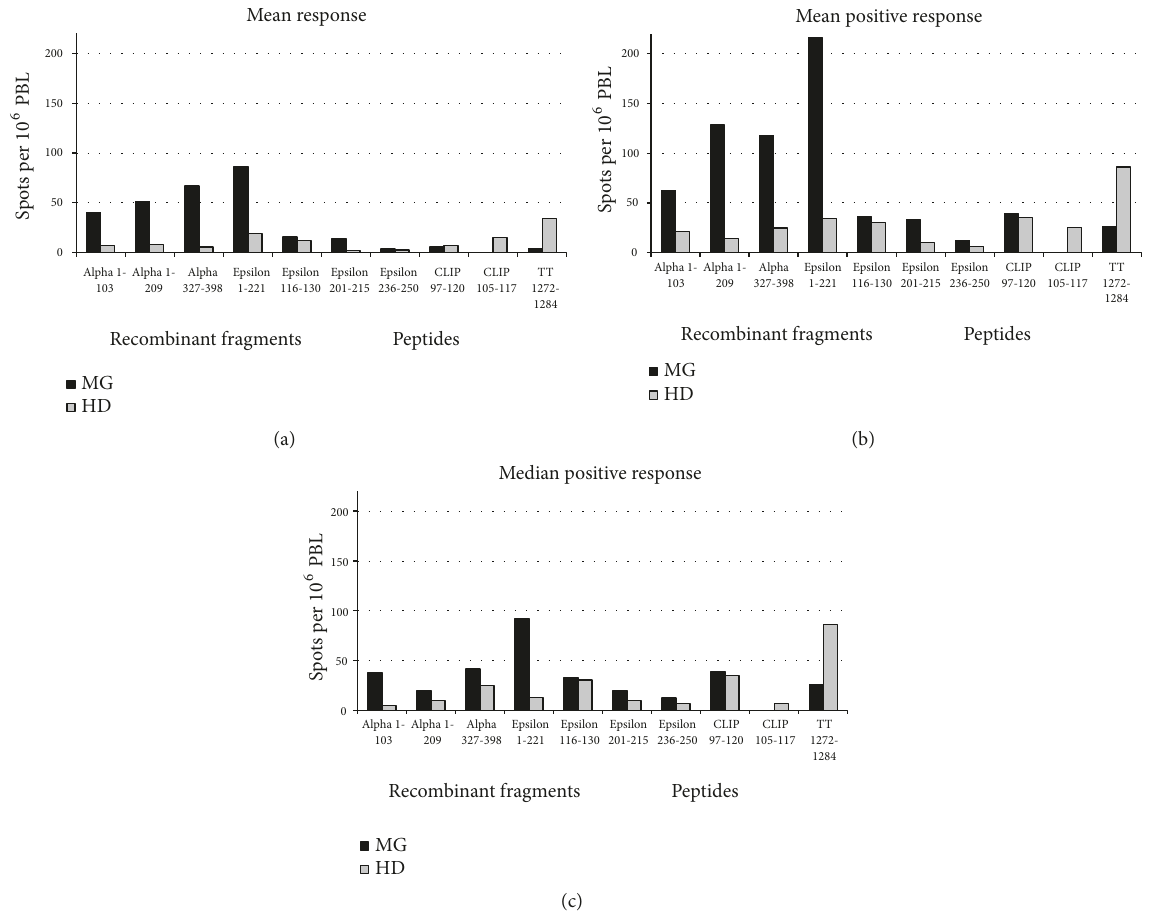
Figure 2: (a) Mean response, (b) mean positive response, and (c) median response of the numbers of IFN- 𝛾 -secreting events among 10 6